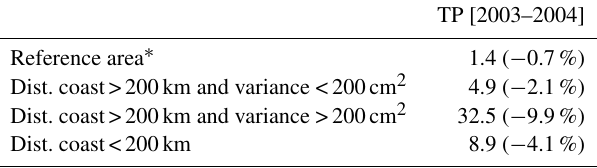
Table 2. Variance of the differences between gridded DT2014 two- sat-merged products and independent TP-interleaved along-track measurements for different geographic selections (unit = cm 2 ). In parentheses: variance reduction (in %) compared with the results obtained with the DT2010 products. Statistics are presented for wavelengths ranging between 65 and 500km and after latitude se- lection (|LAT|<60 ◦